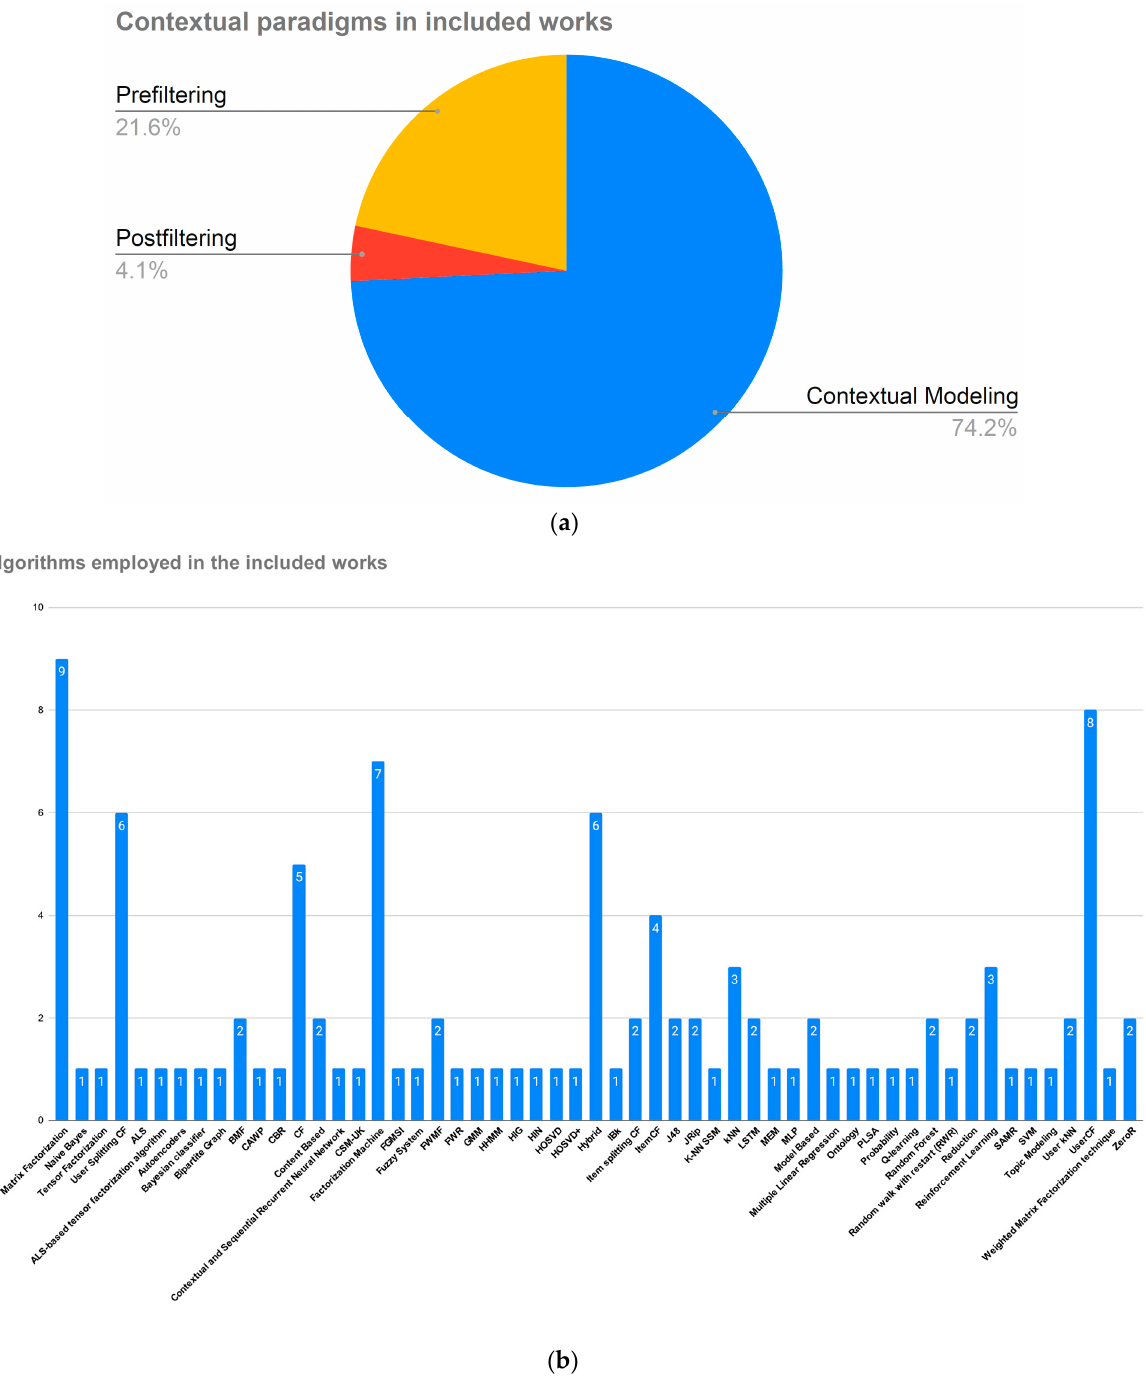
Figure 5. ( a ) Percentages of works employing contextual paradigms ( b ) algorithms found in the included works.